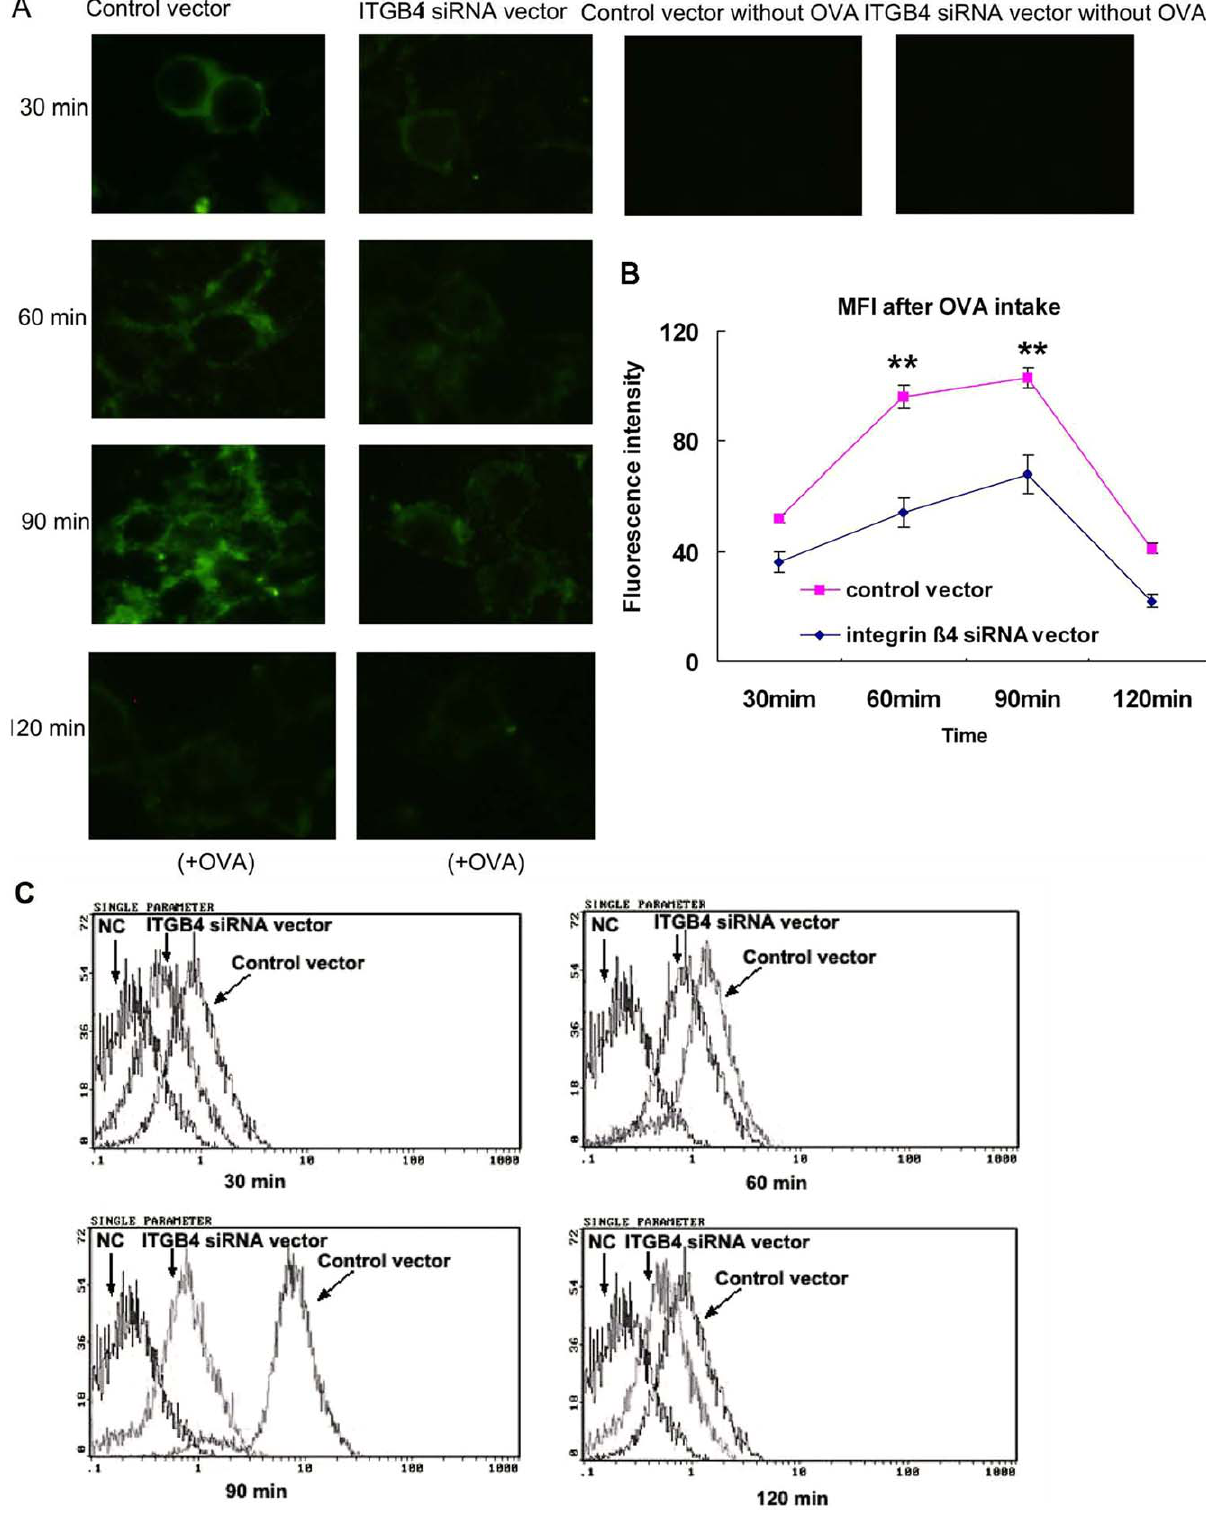
Figure 3. Antigen trafficking was surveyed after ITGB4 was silenced. (A) Control transfected 16HBE14o- cells and ITGB4-silenced cells were grown on coverslips, pulsed with FITC-labeled OVA, washed at different time points, and analyzed through laser confocal microscopy. (B) Quantification of staining intensity in figure 3A. (C) Representative histogranms showing the fluorescence intensity of 16HBE14o- cells from different groups after plused with FITC-labeled OVA. The antigen trafficking ability was determined according to flow cytometry detection at all time points.